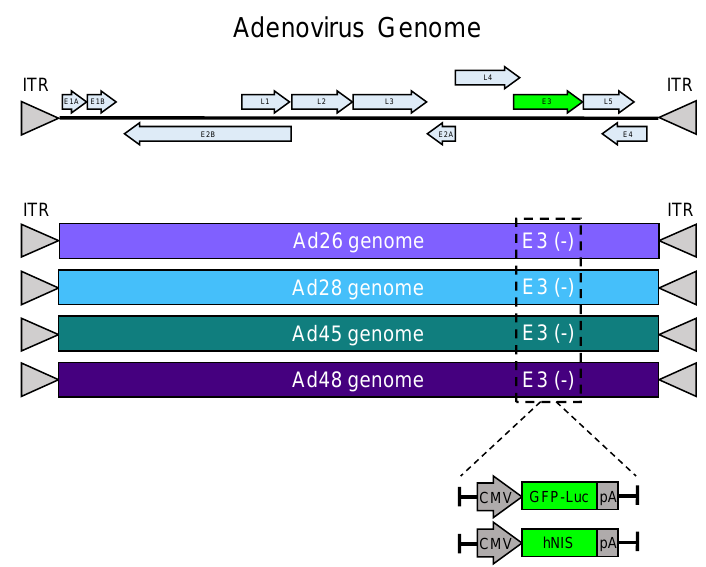
Figure 1. Schematic of recombinant species D oncolytic viruses. A schematic of an adenovirus genome is shown (top). The E3 genes from Ad26, Ad28, Ad45, and Ad48 were replaced with a GFP-Luciferase expression cassette (GFP-Luc) or a human sodium ion symporter (hNIS) gene. Each transgene included a CMV promoter and a flanking polyA tail. Viruses 2020 , 12 , x FOR PEER REVIEW